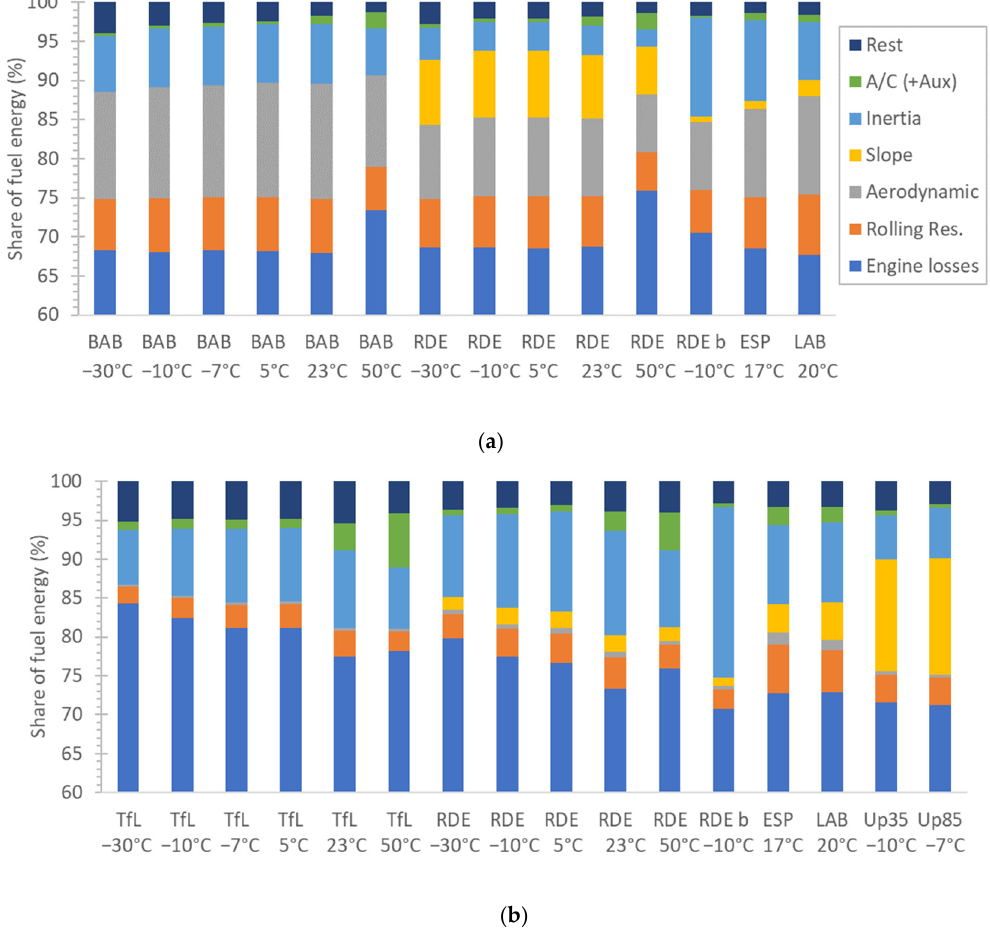
Figure 7. Fuel energy share of various parameters: ( a ) motorway cycles; ( b ) urban cycles.